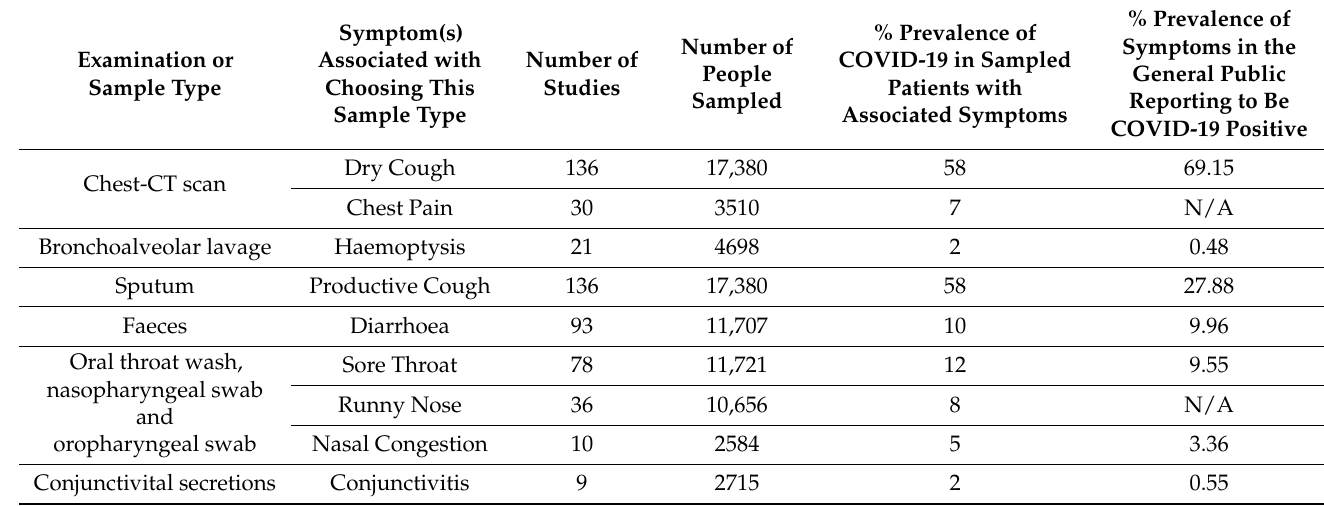
Table 3. The prevalence of COVID-19 within patients presenting with defined symptoms, contrasted against the percentage of those who experience these symptoms, all matched to the appropriate sample type to test for the disease [42,77].